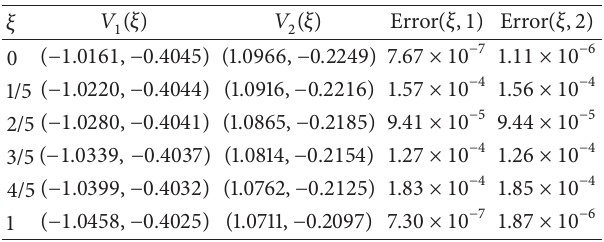
Table 3: Solution and relative error for Example